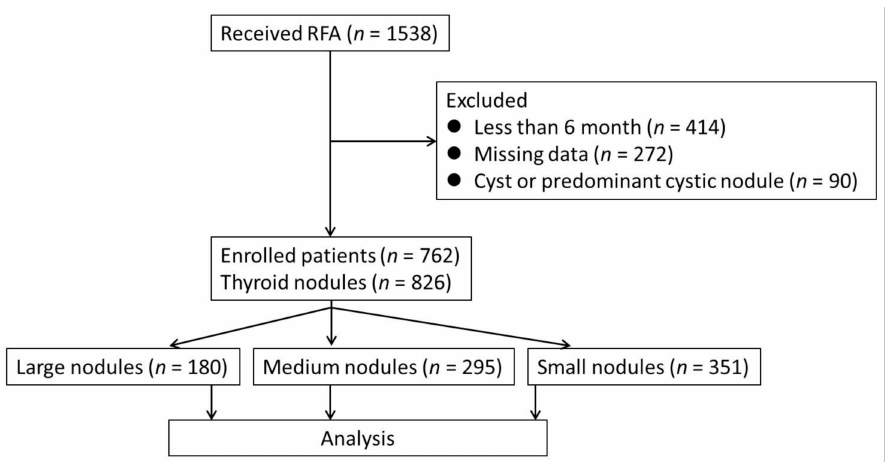
Figure 2. Consort diagram of the